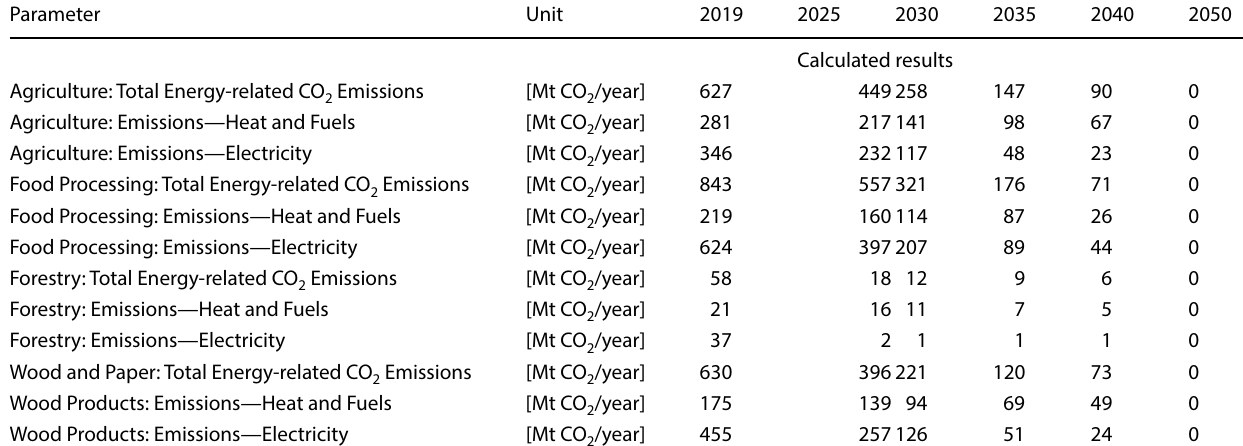
emissions of the analysed sectors under the 1.5 °C energy pathway Table 16 Results: energy-related CO 2 Parameter Unit